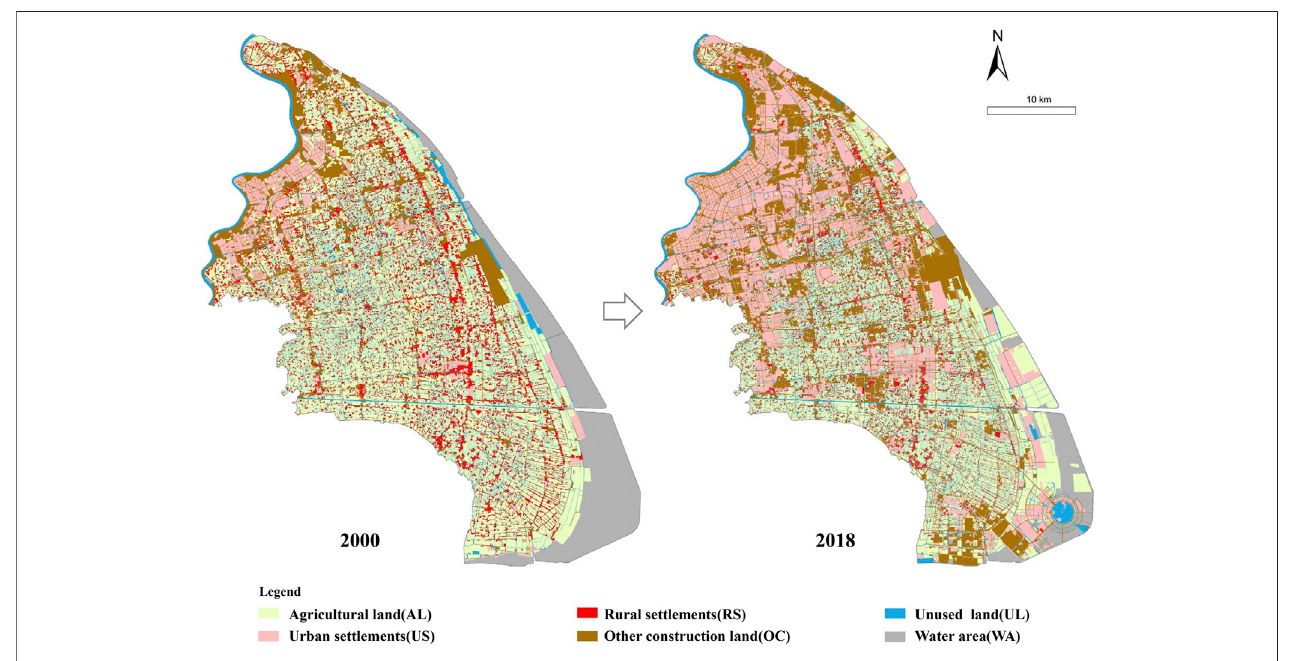
FIGURE 2 | Classi fi ed land-use map of Pudong in 2000 and